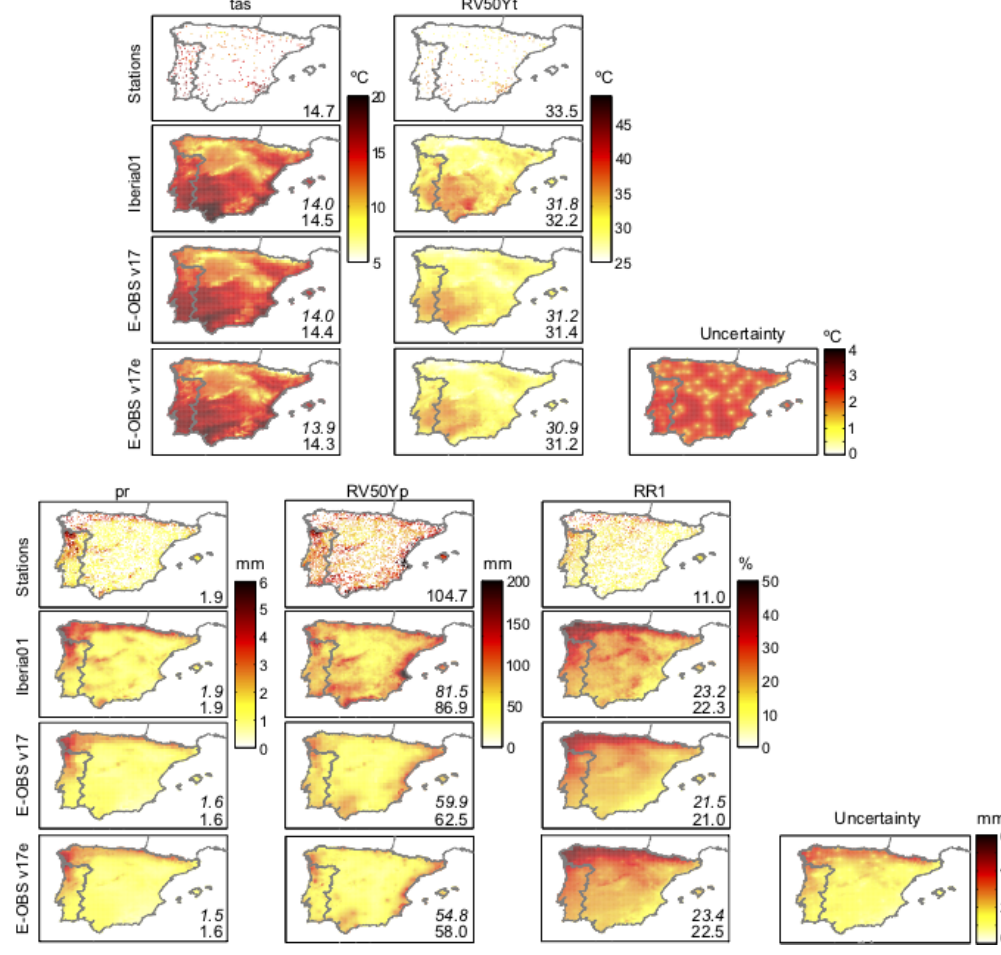
Figure 2. Climatology of the different temperature (top) and precipitation (bottom) indices defined in Table 1, from the stations (local values), Iberia01 (0.1 ◦ resolution), E-OBS v17 (0.2 ◦ ), and E-OBS v17e (0.1 ◦ ), in rows. The climatologies have been obtained by averaging the annual values of the indices (tas, pr, and RR1); in the case of the 50-year return value the index is representative of the whole period. For the ensemble E-OBS version (v17e), the climatology of daily standard deviations of the ensemble values is also shown (characterizing E-OBS observational uncertainty). The numbers shown in each panel correspond to the spatial mean values, calculated for gridded datasets averaging over all grid boxes (top, in italics) or over the grid boxes closest to the stations (bottom), to provide a fair comparison with the station mean values in the top panels (in particular these numbers are used to assess the biases of the different gridded